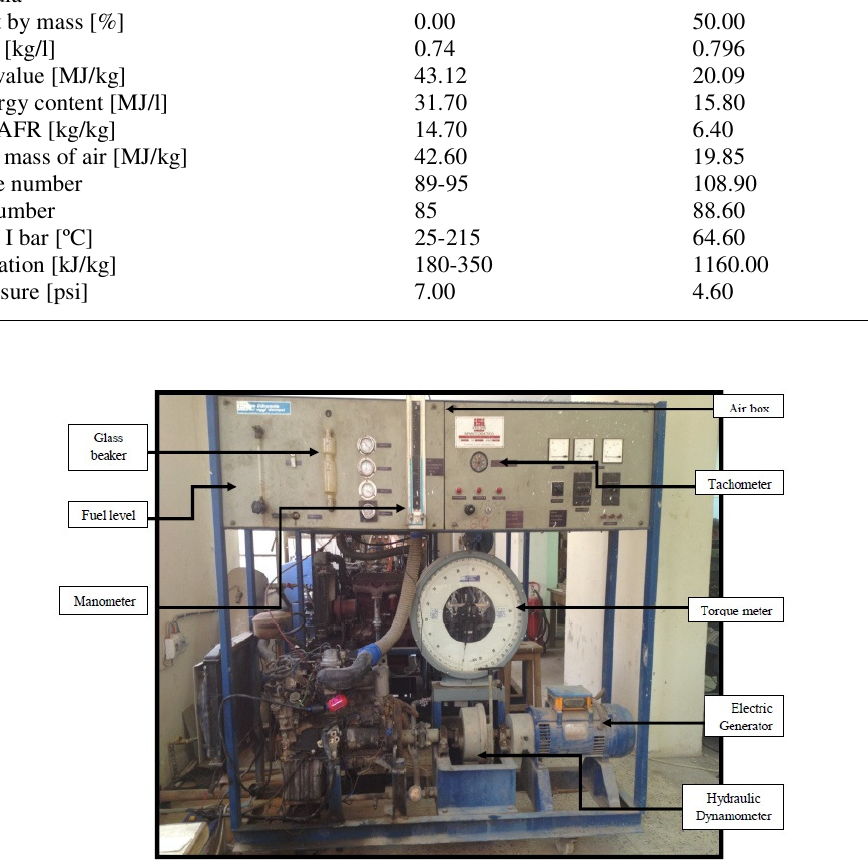
Fig. 1. The experimental rig of SI engine.